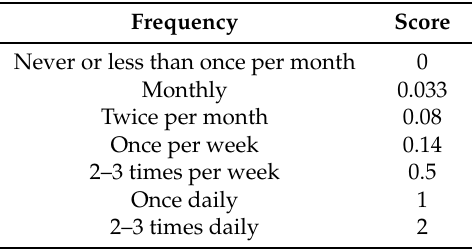
Figure 1. Consort diagram for recruitment of participants. Table 1. Food Frequency